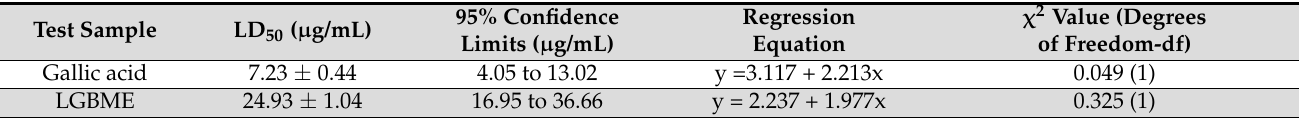
Table 3. Cytotoxic activity of LGBME.